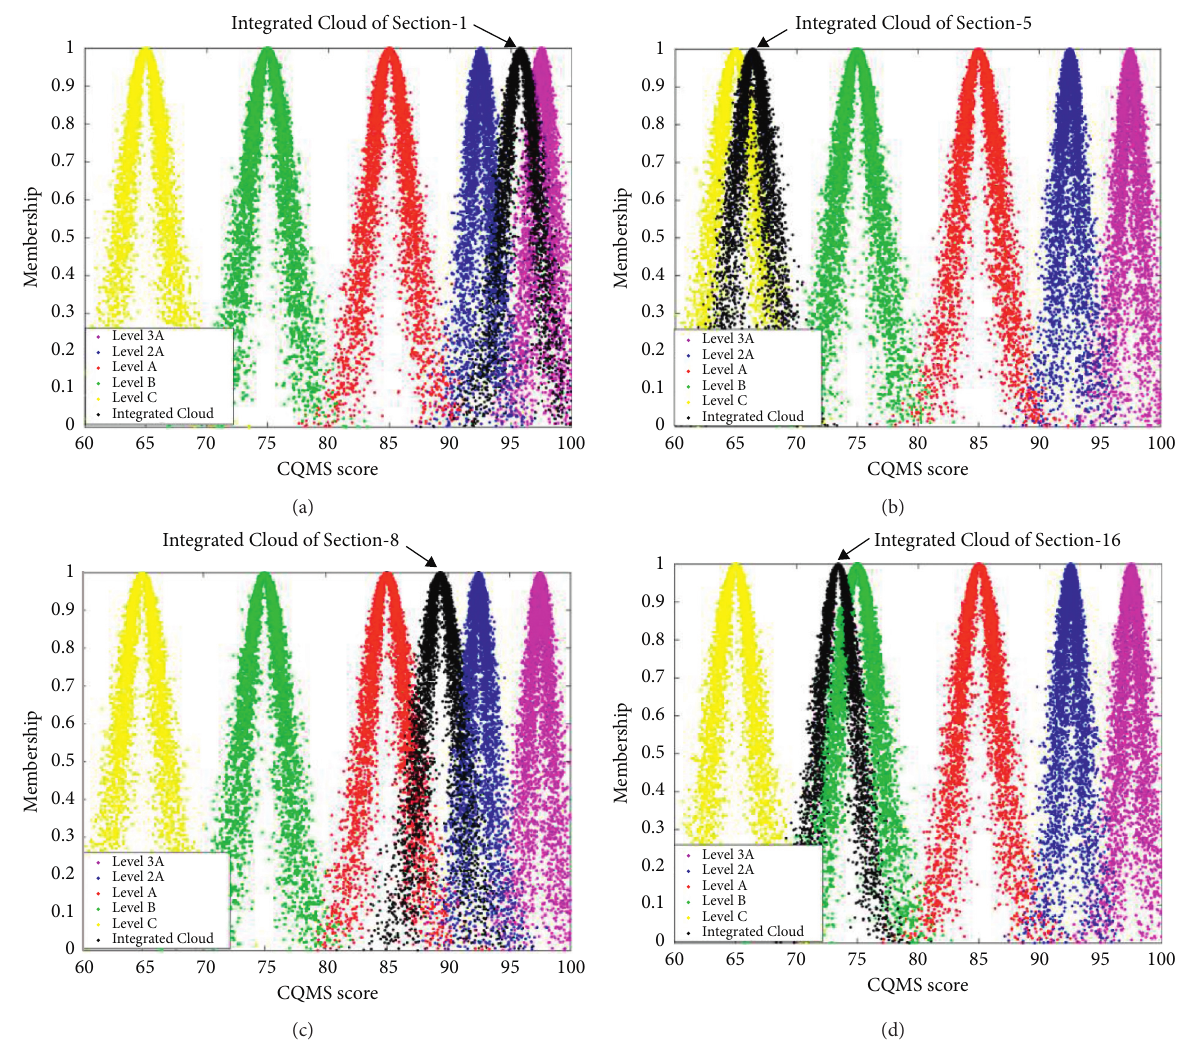
Figure 6: Comparison of CQMS evaluation integrated cloud maps of sections 1, 5, 8 and 16. (a) Line of section 1. (b) Line of section 5. (c) Line of section 8. (d) Line of section